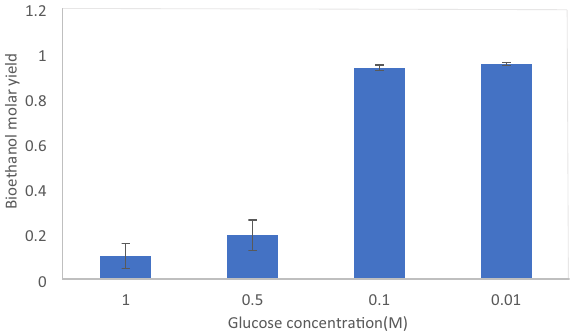
Figure 2. Ethanol molar yield at different glucose concentrations without adding any expensive cofactors in Z. mobilis crude extract. Values present averages (n ≥ 3) and error bars present standard deviation.